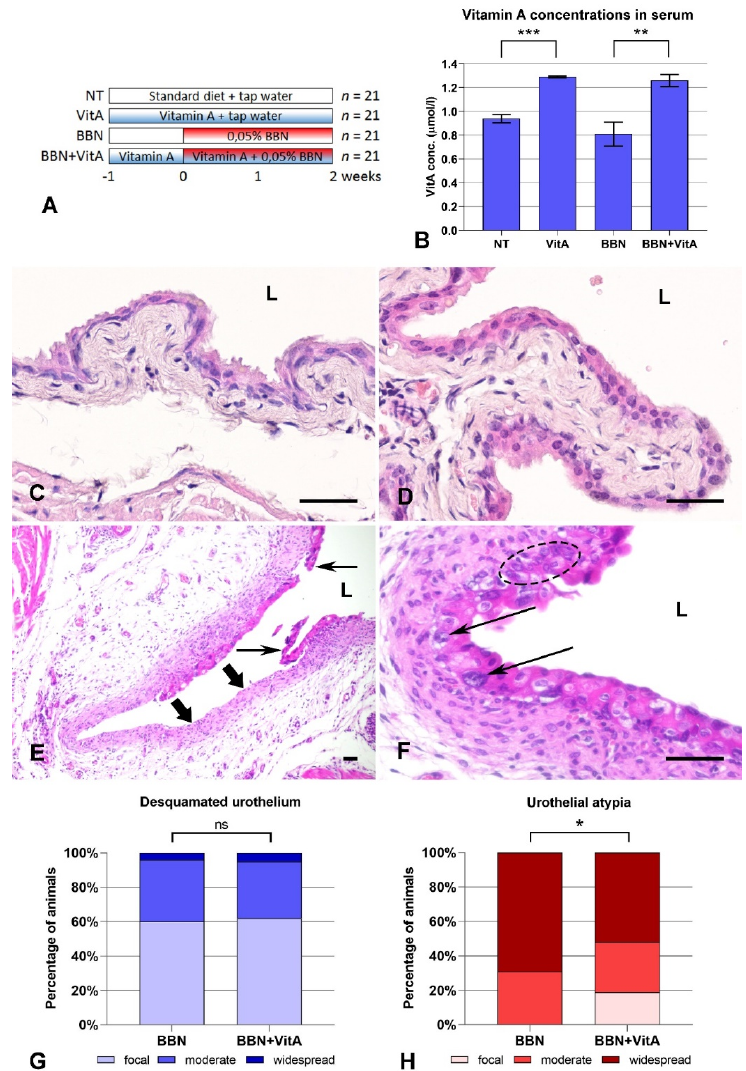
Figure 1. Treatment regiments, vitamin A serum concentrations, and histopathological changes in urothelium after N -butyl- N -(4-hydroxybutyl) nitrosamine (BBN) treatment and vitamin A rich diet: ( A ) Four groups of animals treated with standard diet (NT), vitamin A rich diet (VitA), BBN in drinking water (BBN), and BBN in drinking water and vitamin A rich diet (BBN + VitA); ( B ) vitamin A serum concentrations of NT ( n = 6), VitA ( n = 6), BBN ( n = 9), and BBN + VitA ( n = 9) groups of animals (tested by ANOVA, F -test, and two-sided Student’s t -test; *** p = 0.0001, ** p = 0.0011). Hematoxylin and eosin staining: Normal urothelium of ( C ) NT group and ( D ) VitA group showing characteristic three-layered urothelium with superficial umbrella cells; ( E ) desquamated urothelium (thin arrows) in BBN group with denuded basal lamina and lamina propria (thick arrows). Similar areas were observed in BBN + VitA group; ( F ) urothelium of BBN + VitA group with large pleomorphic and hyperchromatic nuclei with conspicuous nucleoli and irregular contours (thin arrows), with nuclear crowding (dashed ellipse) and loss of cell polarity, characteristic of urothelial atypia. Similar areas, but even more widespread, were observed in BBN group. L, lumen of the bladder. Scale bars = 50 μ m. Histopathological evaluation of ( G ) desquamated urothelium and ( H ) urothelial atypia in BBN ( n = 21) and BBN + VitA ( n = 21) groups (tested by ANOVA, F -test, and two-sided Student’s t -test; * p < 0.05; ns, no statistically significant di ff erence). In NT ( n = 21) and VitA ( n = 21) groups, the percentage of animals with desquamation of urothelium or urothelial atypia was